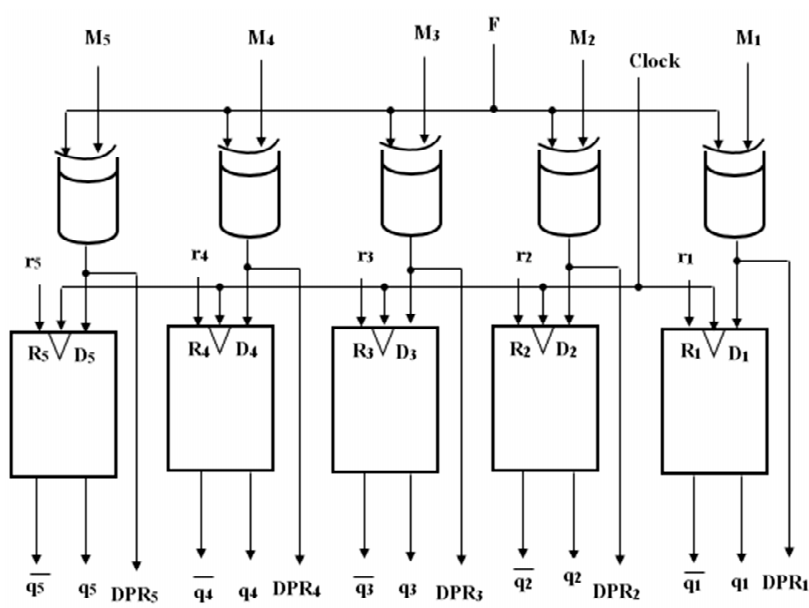
Figure 6. Logic diagram of Block V.